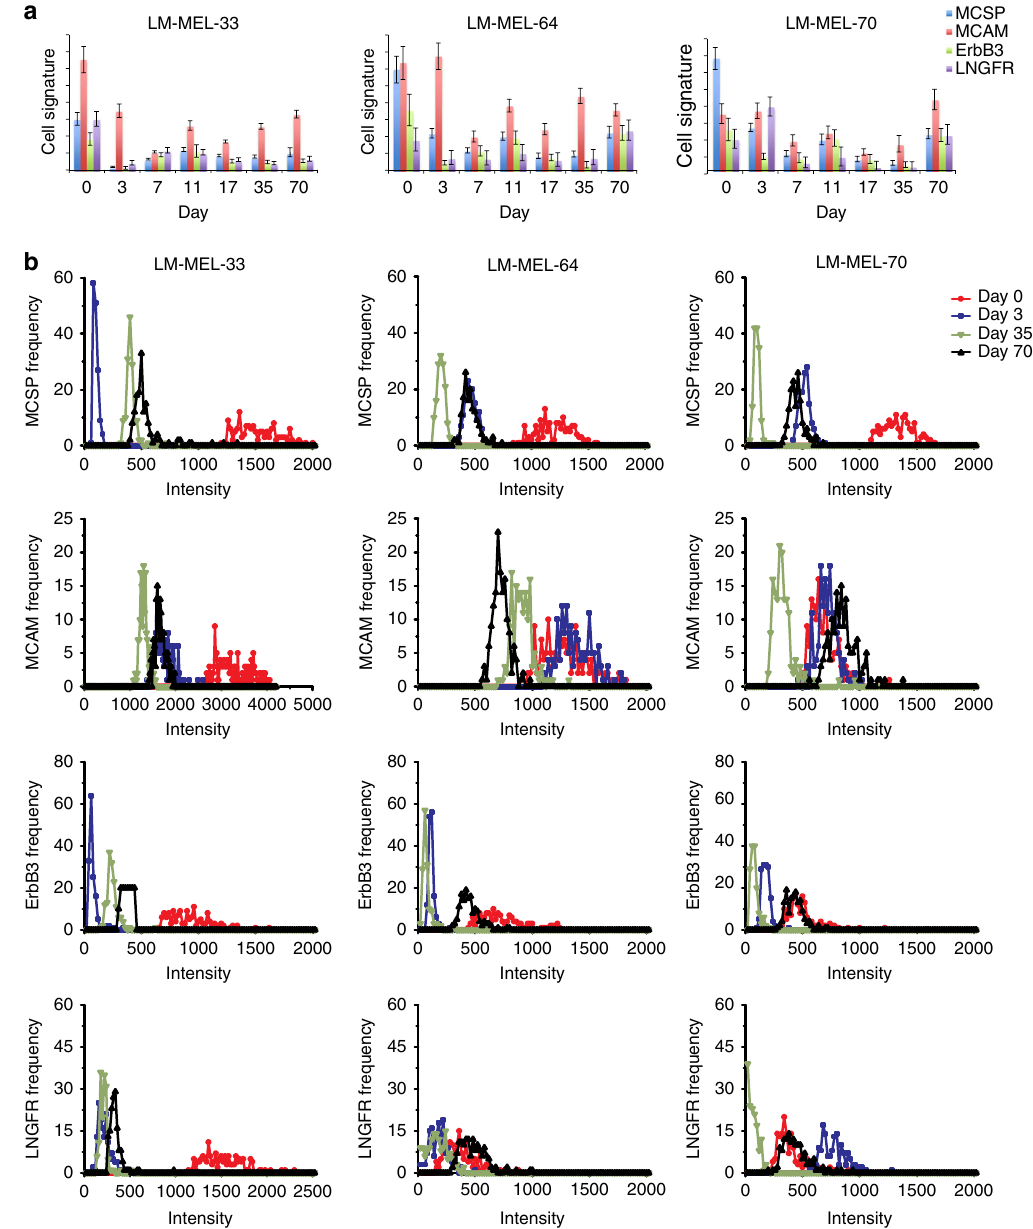
Fig. 3 Cell phenotypes in response to drug treatment. a Cell signature and b distribution of cell surface marker expression levels before and during drug treatment (days 3, 35, and 70). Data in a are mean ± s.d. with 150 measurements. Each curve in b is calculated by 150 measurements of the bulk of